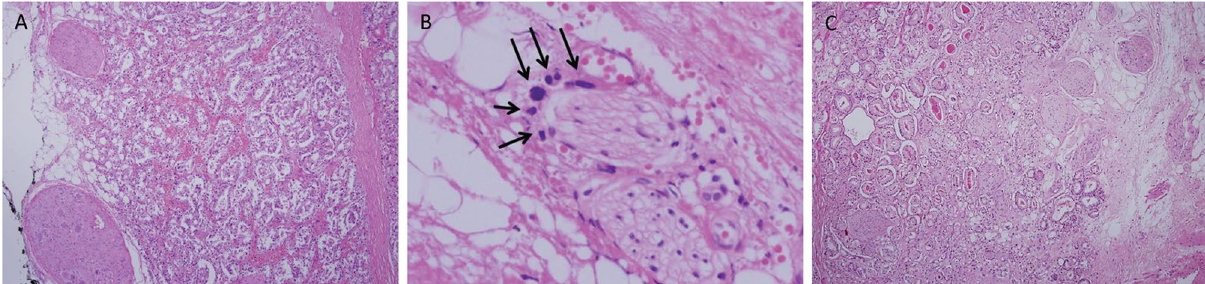
Figure 1. Gleason grade and extraprostatic extension (EPE). ( A ) Gleason patterns in the areas of EPE paralleled the dominant tumor pattern, usually Gleason patterns 4 and 5. ( B ) A few cancer cells scattered around the nerve outside of the capsule were often encountered and can indicate Gleason pattern 5. ( C ) In a few cases of PGG2 and 3, EPEs were scored as Gleason Grade 3, whether alone or more commonly mixed with Grade